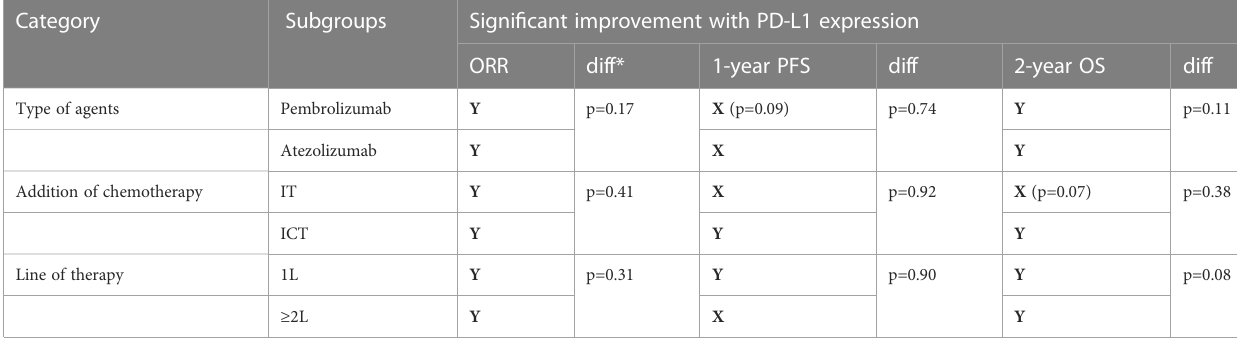
TABLE 2 Subgroup